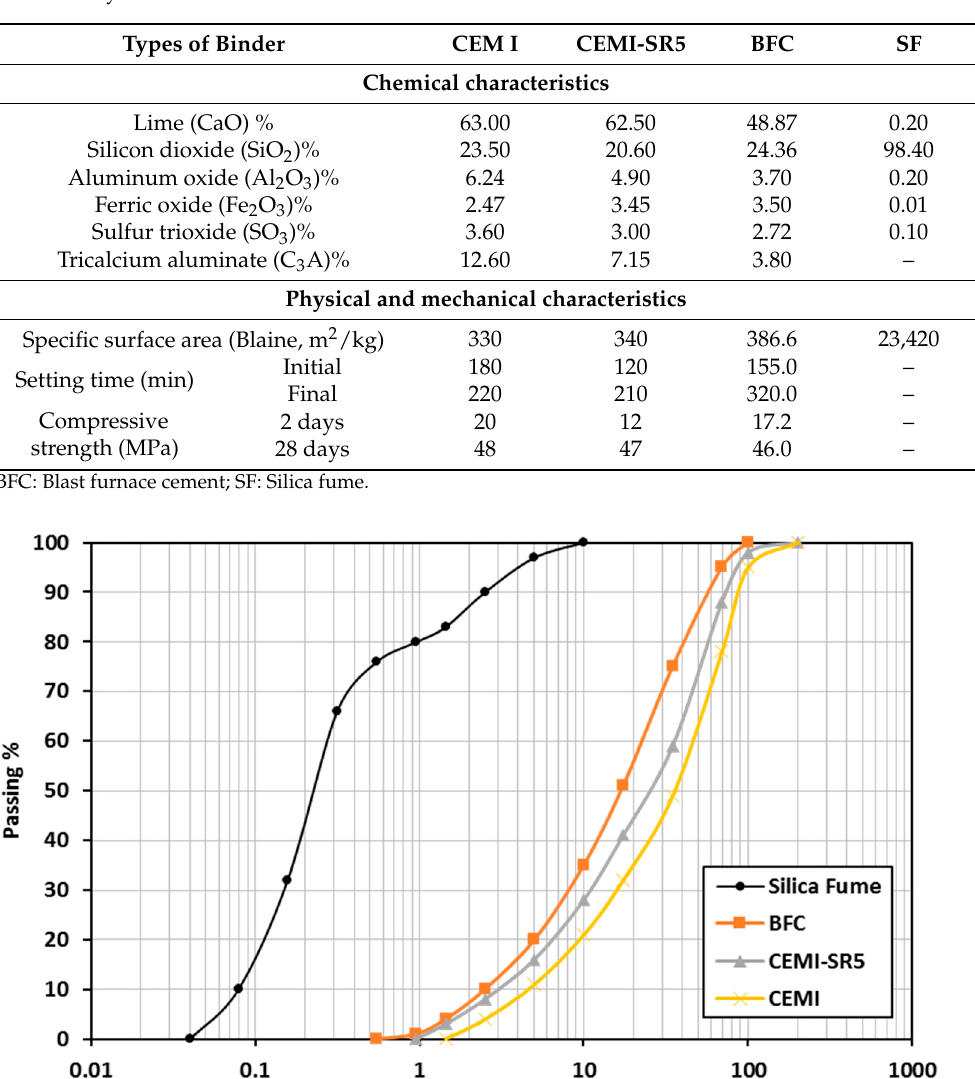
Table 2. Physical and chemical characteristics of binder used.